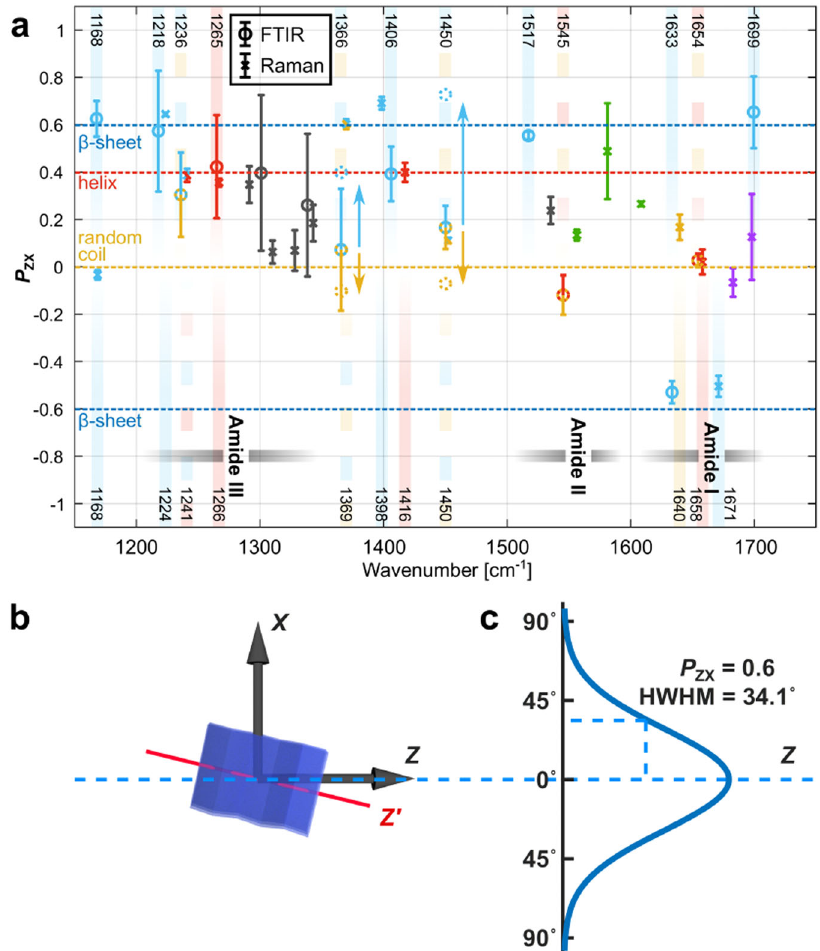
Fig. 4 Orientational characteristics. a P ZX -values calculated for each FTIR (circles) and Raman (crosses) peak. Color assignments between each color on the peaks and corresponding protein structure are same as Fig. 2. Vertical gradient bands indicate the postion of FTIR (upper half) and Raman (lower half) peaks in corresponding colors, respectively. The horizontal yellow, red, and blue dashed lines are located at P ZX = 0, 0.4, and ±0.6, respectively. The IR and Raman data points are arithmetic mean values. Vertical error bars on IR data points are derived by minimizing mean squared error (MSE) and error propagating method. Vertical error bars on Raman data points are standard deviations of P ZX values calculated from repeated noisy fi tting processes (number of fi ttings, n F = 15) (see details in Supplementary Section 5). Treating β -sheet ( ≈ 44%) and amorphous ( ≈ 56%) fractions separately for the 1366 cm − 1 and 1450cm − 1 peaks leads to split P ZX values, one for each fraction, indicated by arrows and dotted circles. b A β -sheet nanocrystal model featuring an angle between its internal symmetry axis Z ’ and the Z axis of the ribbon (the axis of the nano fi brils). c When P ZX = 0.6, the orientation distribution of β -sheets within the nano fi brils features a normal distribution with a half width at half maximum (HWHM) of